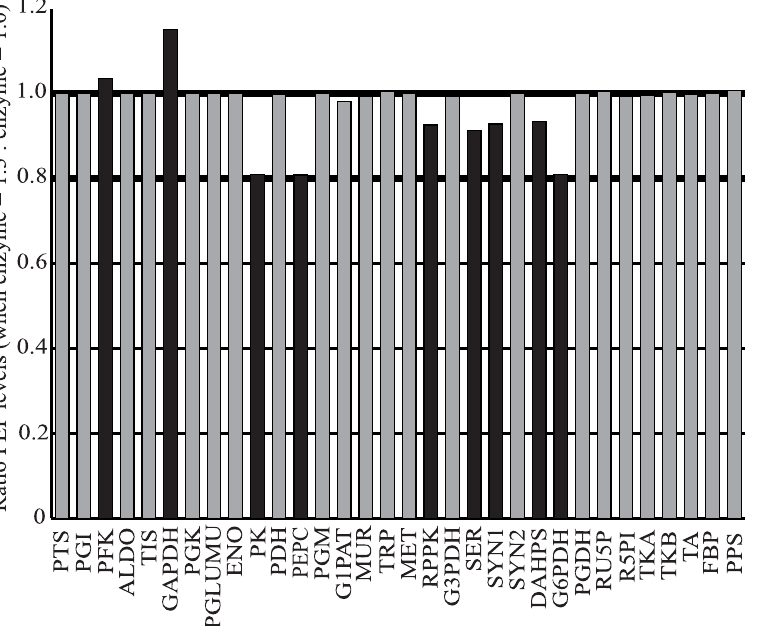
Figure 2. Sensitivity analysis identifies the enzymes most important for PEP production. The bar graph shows the ratio of PEP levels when the indicated enzyme level is raised 50% above its normal, steady state level (a value of 1.5 in the simulation). Upregulated enzymes that caused a change greater than 2% change in PEP levels (black bars) were deemed significant for PEP production.